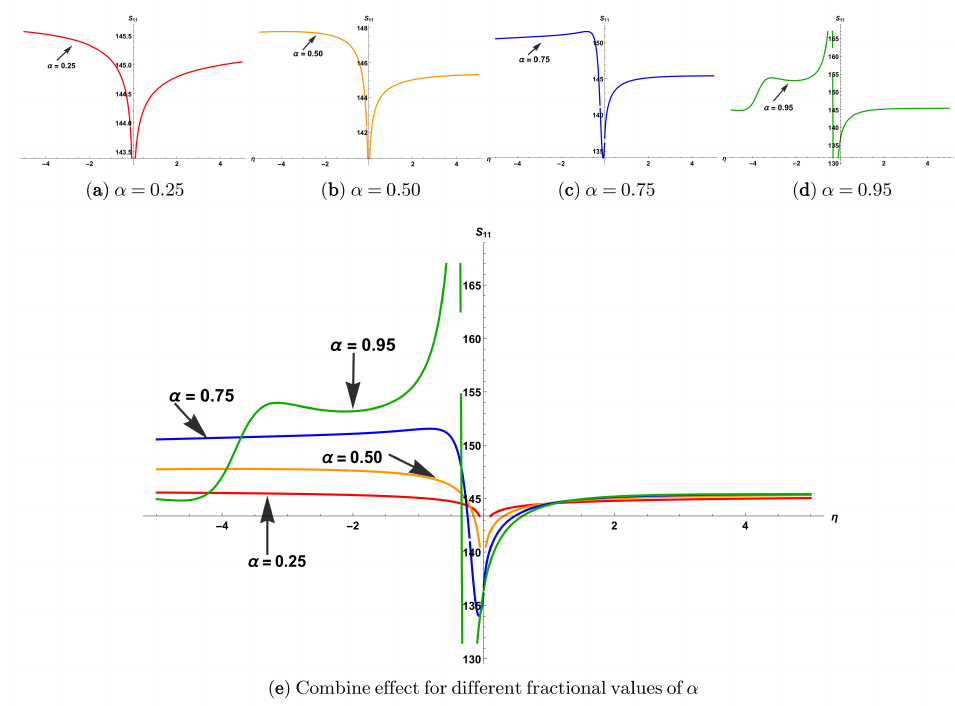
Figure 11. A 2D graphical representation for S 11 .